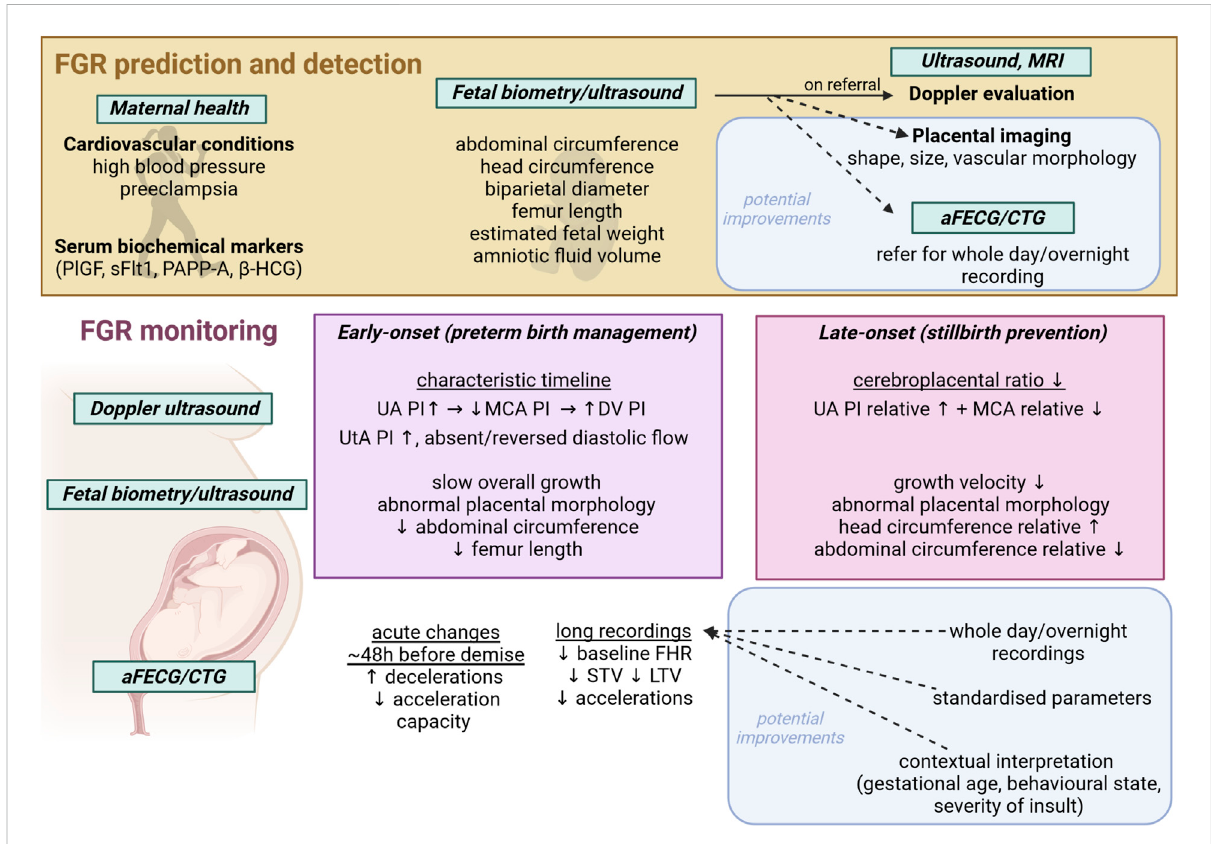
FIGURE 1 Schematic showing current FGR detection and monitoring techniques and modalities, with potential avenues for improvement. aFECG, abdominal fetalelectrocardiogram; CTG,cardiotocogram; MRI,magneticresonanceimaging;UA,umbilicalartery;MCA,middlecerebral artery;DV, ductus venosus; PI, pulsatility index; STV, short term variability; LTV, long term variability; PlGF, placental growth factor; sFlt1, soluble fms-like tyrosine kinase-1; PAPP-A, pregnancy associated plasma protein A; β -HCG, beta human chorionic gonadotropin; SPINT, serine protease